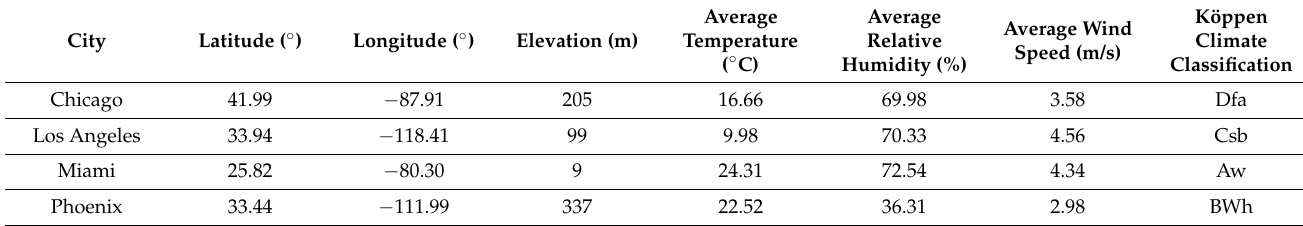
Table 1. Geographical information for four climates.